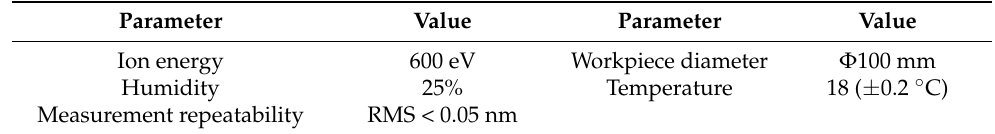
Table 1. Experimental